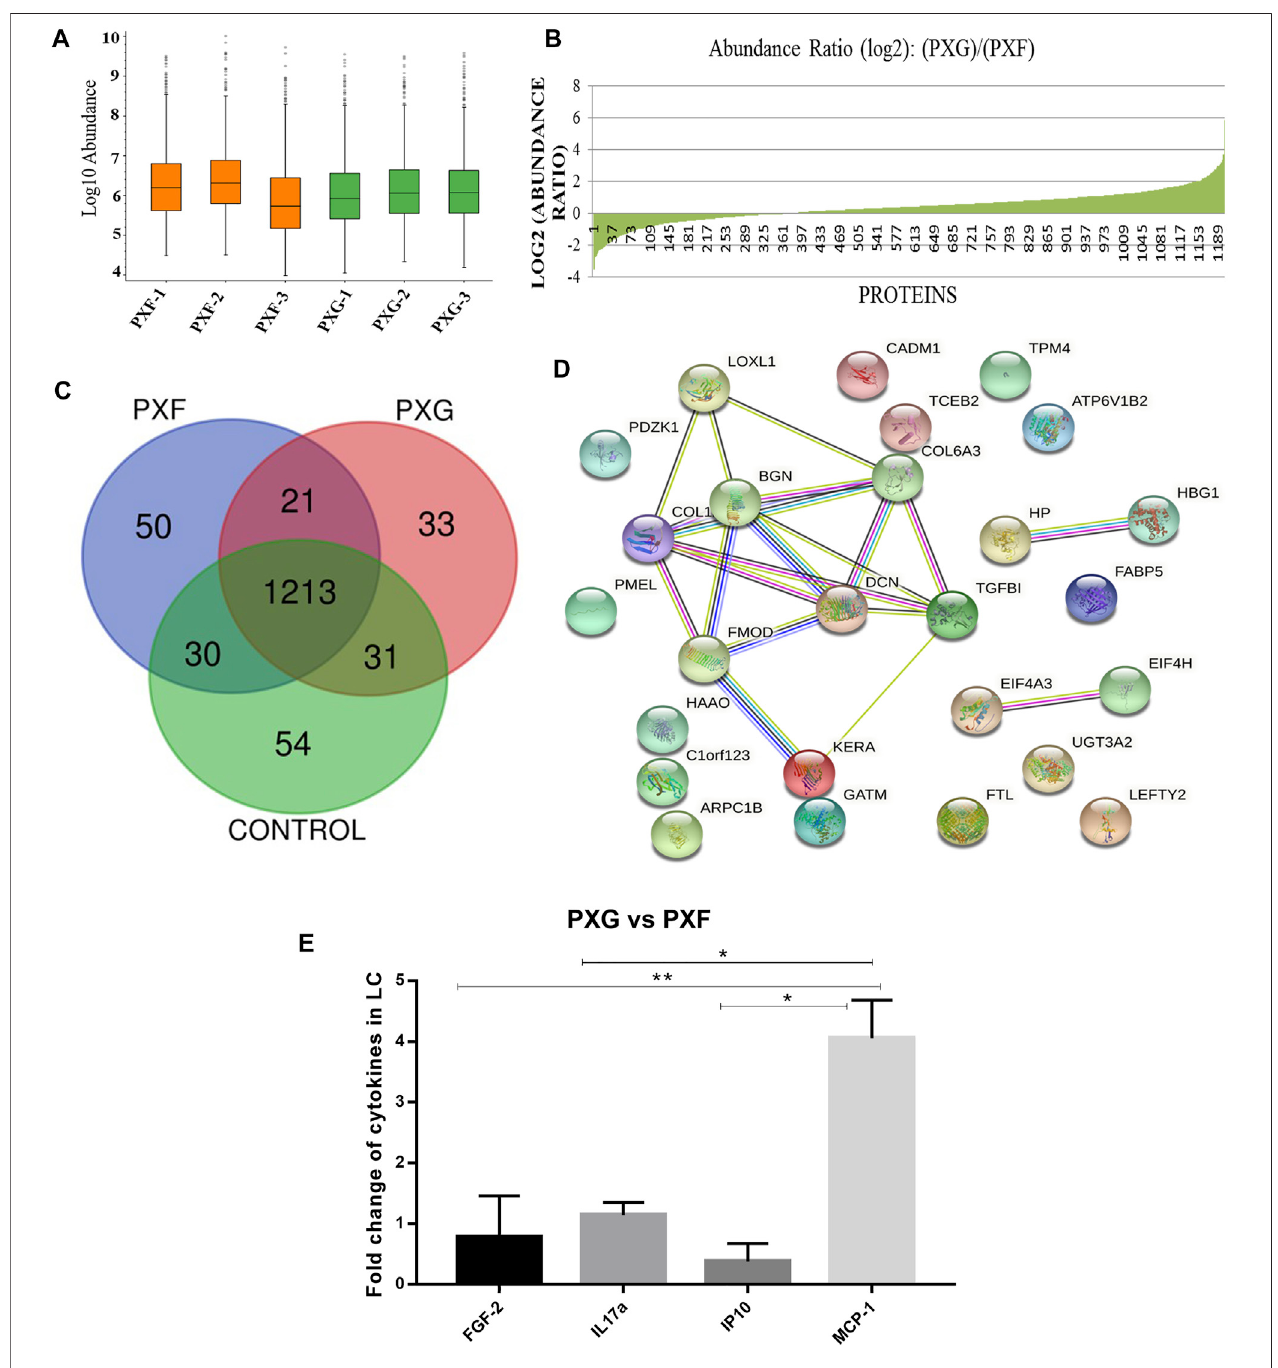
FIGURE 1 | Protein pro fi les in LC with PXG compared to PXF. (A) Box plot of the protein expressions in each sample of PXF and PXG ( n = 3), showing very little variabilityamongthetriplicatesamples. (B) Abundanceratios(log2)ofproteinsinPXFvs.PXGwithoverexpressedorunderexpressedproteinsindicatedinthegraph. (C) Vennlistwasderivedofall1,433proteins inPXFvs. control, PXGvs. control, and PXFvs.PXG fortheidenti fi cation ofcommon and uniqueproteins inPXFandPXG. (D) Network generated ofprotein – protein interactomes withthe top27proteins identi fi ed inPXG ( > 2.5 folds)involved inextracellular homeostasis and protein binding usingSTRINGanalysis. (E) Foldchangeofcytokines/chemokinesusingabioplexkitassaywithPXGcomparedtoPXF.Means±SEMshown,* p < 0.05,** p < 0.01,one- way ANOVA post hoc t -test with Tukey correction, PXF-pseudoexfoliation, and PXG-pseudoexfoliation glaucoma.